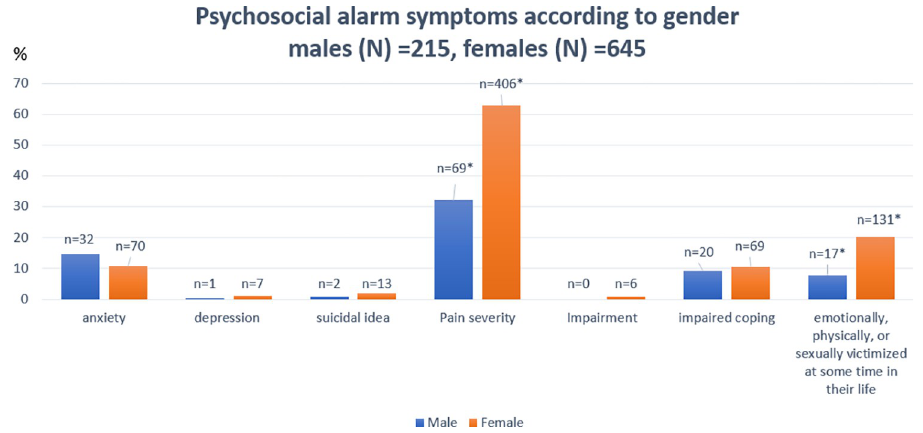
Fig 3. Psychosocial alarm symptoms according to gender ( � represents statistically significant).